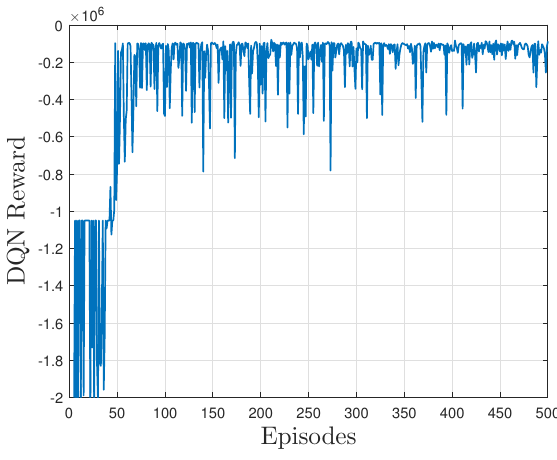
Figure 10. Reward sum progression.